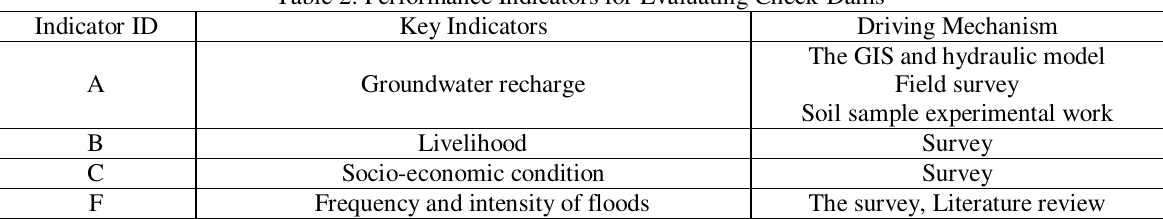
Table 2: Performance Indicators for Evaluating